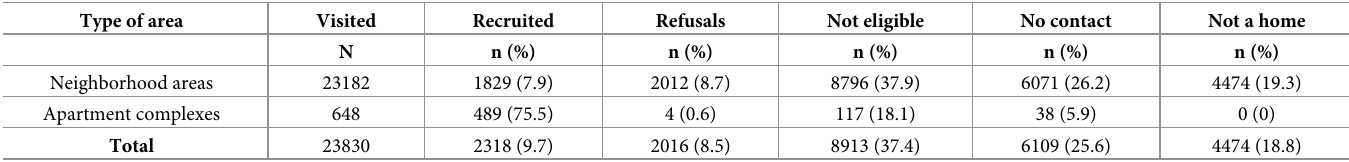
(86%) unscheduled visits. For simplicity, we grouped the 38 communities into two main cate- gories to provide aggregate level statistics for apartment complexes and neighborhood areas (Table 2). Among 23,830 randomly selected homes and apartment building units, a total of 4,090 participants and 9.7% homes were recruited. Among other homes visited, 37.4% were Table 2. Final visit outcomes among households visited. Type of area Visited Recruited Refusals Not eligible No contact Not a home Neighborhood